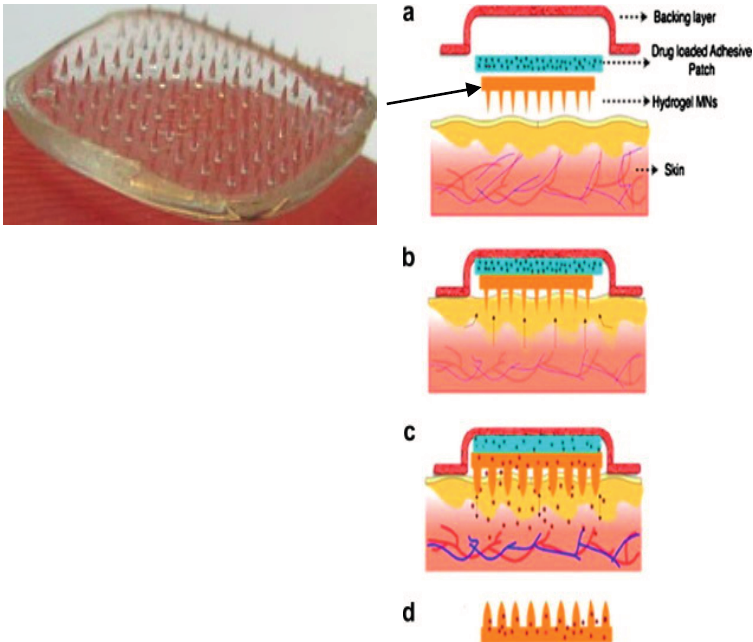
Figure 16. Novel hydrogel-forming MN facilitate controlled transdermal drug delivery. ( a ) An expanded view of the backing layer, drug-loaded adhesive patch and solid